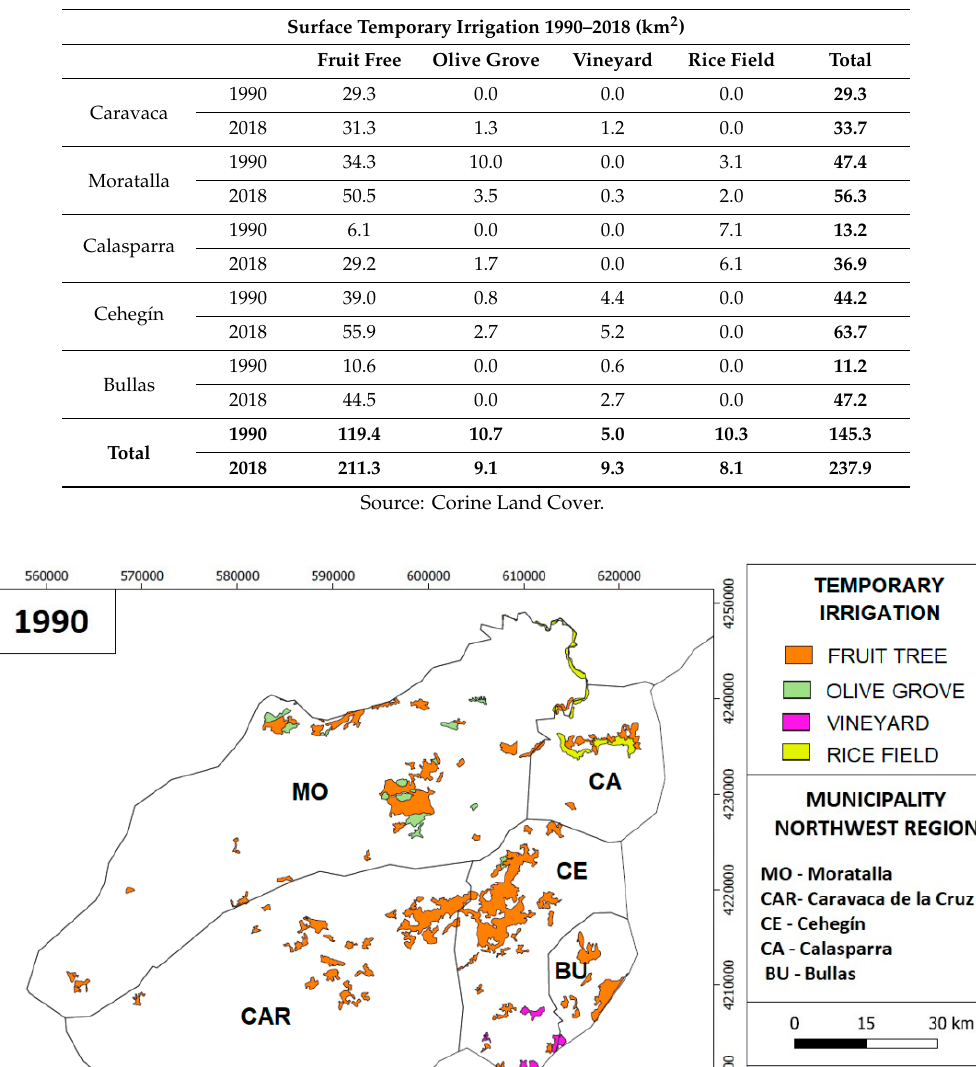
Table 6. Evolution of temporary irrigation crops (1990–2018).